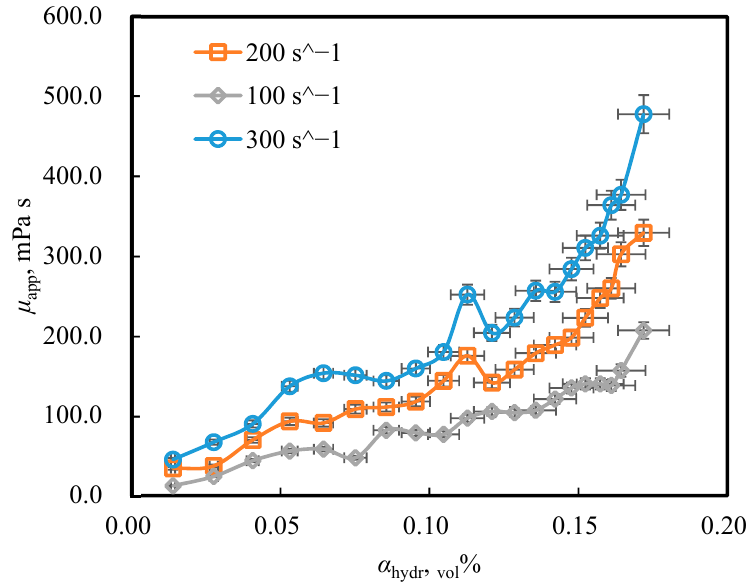
Figure 6. Evolution of apparent viscosity of CO 2 hydrate slurry along with hydrate concentration increasing under shear rate at 100, 200 and 300 s − 1.